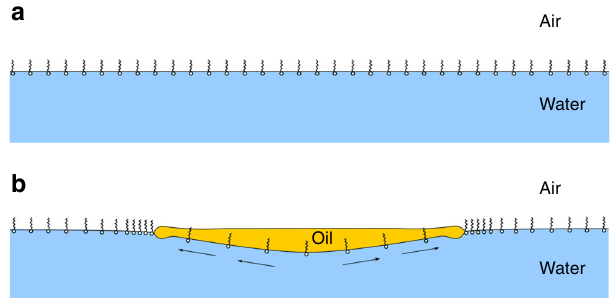
Fig. 8 Sketch of the early evolution of the CTAB distribution resulting from the deposition of the drop. a The surface concentration of CTAB at the air/ water interface is initially uniform; b the minimum area per adsorbed molecule being larger at the oil/water interface, CTAB is swept away and accumulates provisionally ahead of the fi lm, forcing the surface tension γ water/air to decrease abruptly around the contact